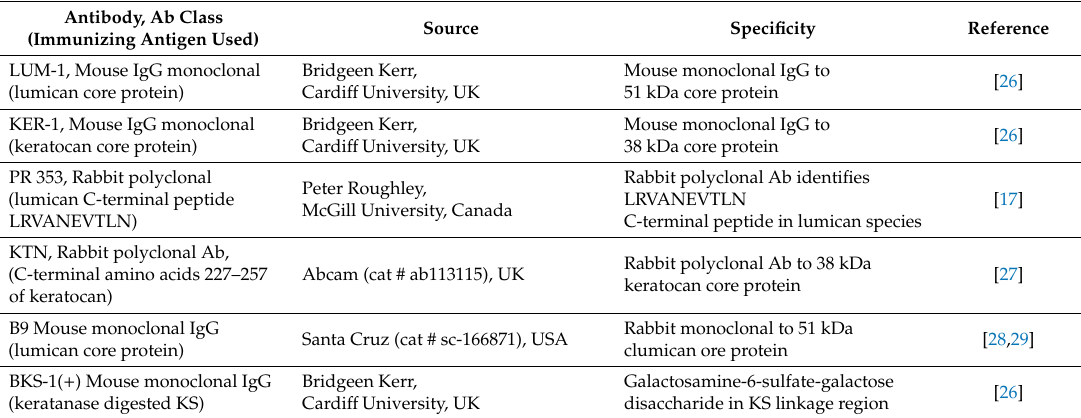
Table 1. Keratocan and lumican antibodies used in this